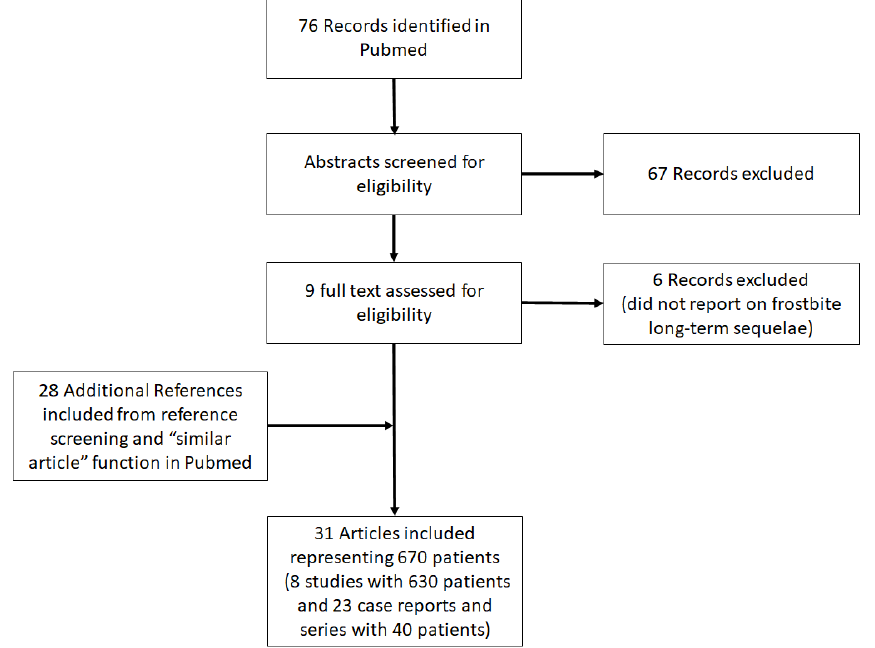
Figure 2. Preferred Reporting Items for Systematic Reviews and Meta-Analyses (PRISMA-ScR) flow chart for reference/literature selection [50].